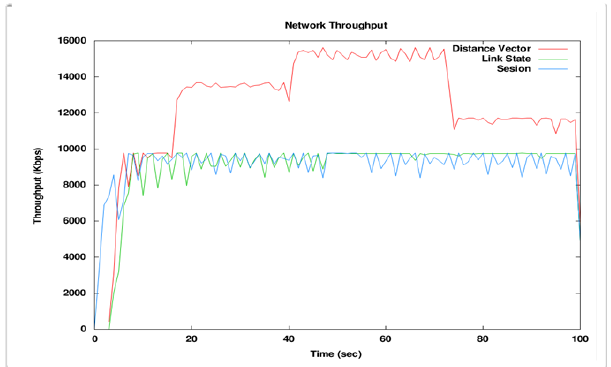
Figure 5: Throughput Utilization for Distance Vector, Link State and Session Routing